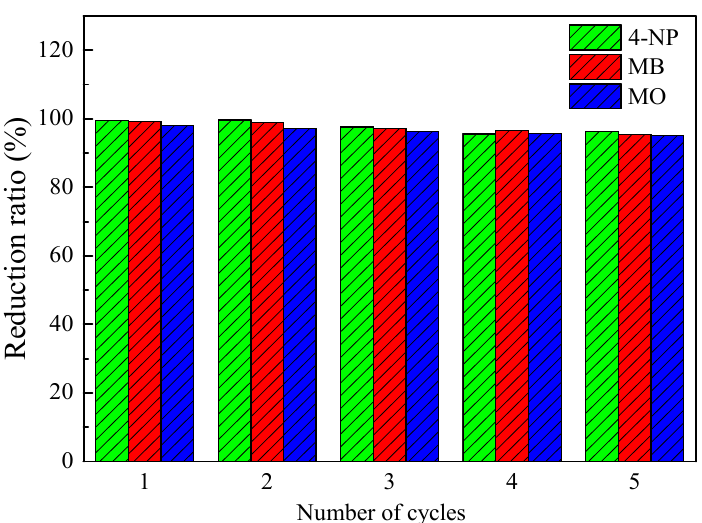
Figure 6. Reduction conversion ratio of 4-NP, MB, and MO after five successive cycles using the carbon-doped CuO/Fe 3 O 4 catalyst.